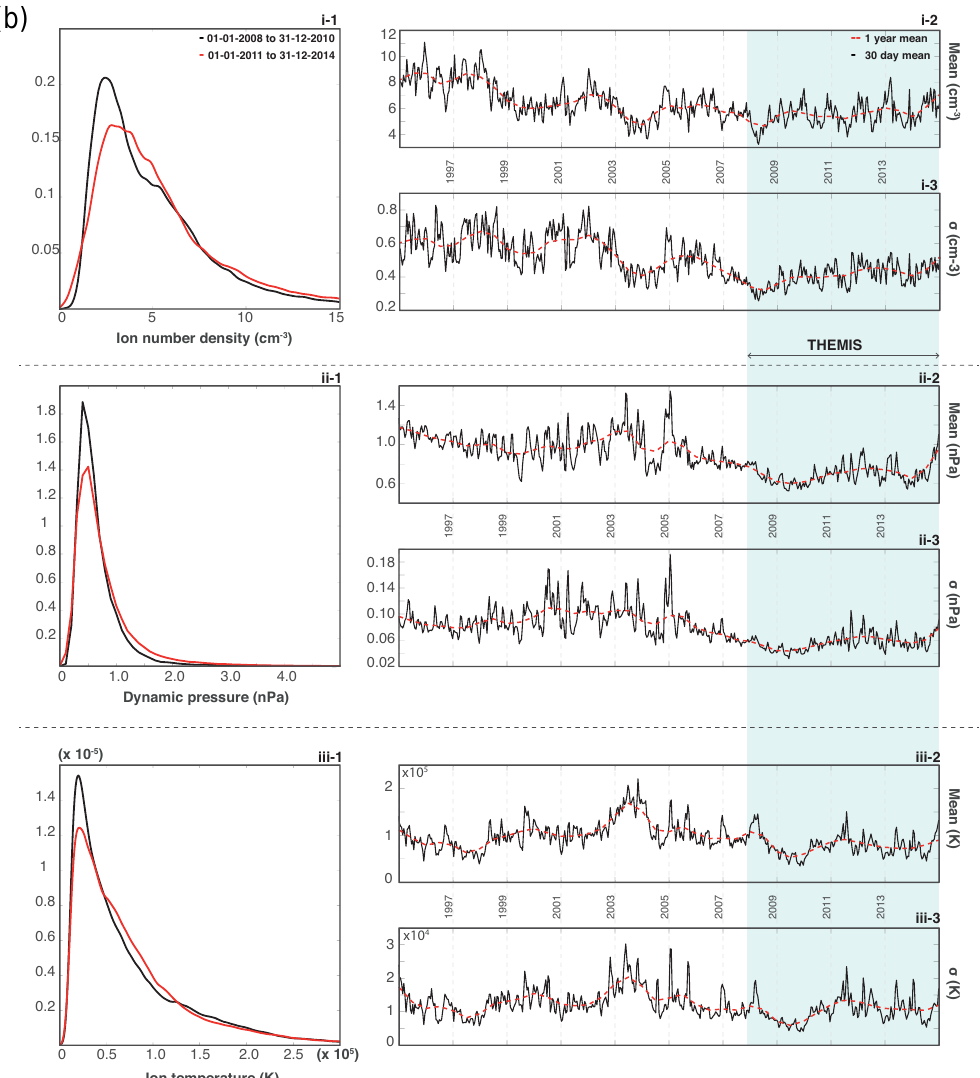
Figure 2. (a) Solar wind magnetic field strength (i-1 to i-3), plasma velocity (ii-1 to ii-3) and Alfvén Mach number (iii-1 to iii-3) over two solar minimum cycles between 1995 and 2015. Each panel (i to iii) presents a distribution i(1), running mean (2) and standard deviation σ (3). The two curves in each distribution panel were compiled using the period of 1 January 2008–31 December 2010 and 1 January 2011–31 December 2014. The blue shaded region indicates the range of years covered by the THEMIS mission. The black and red lines in the time series plots show running averages of 30days and 365days, respectively. (b) Solar wind ion number density (i-1 to i-3), dynamic pressure (ii-1 to ii-3) and ion temperature (iii-1 to iii-3) over two solar minimum cycles between 1995 and 2015. The colour coding and the panel arrangement in this figure are identical to that of (a)